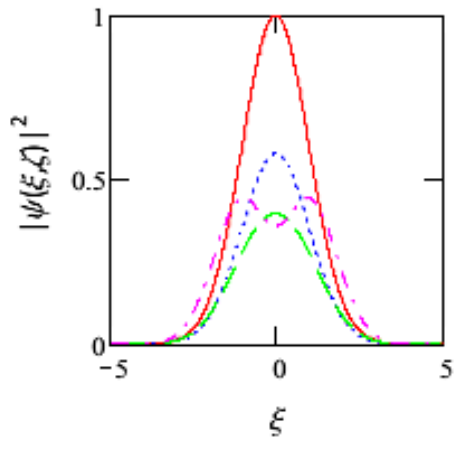
+ ψ 2 of the vector ψ for the input 2 1